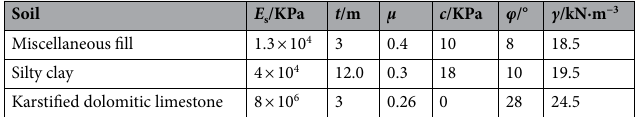
Table 3. Parameters of